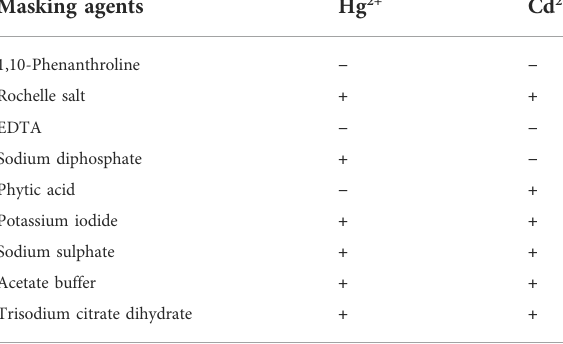
TABLE 1 Masking agent screening